Question: Express in one sentence what the figure is showing.
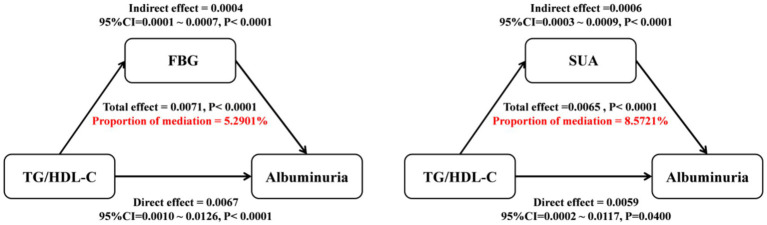
Answer: Mediating effects of FBG, SUA on the association between TG/HDL-C and albuminuria risk. The model adjusted for age, gender, smoking status, drinking status, hyperlipidemia, hypertension, e-GFR, BMI, HbAlc and HOMA-IR. Direct effect: association independent of mediators. Indirect effect: association via FBG (5.29%) and SUA (8.57%).